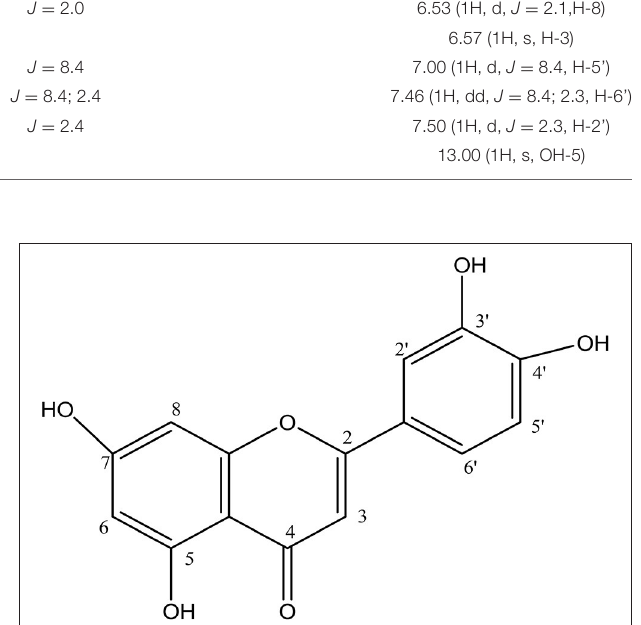
FIGURE 11 | Structure of